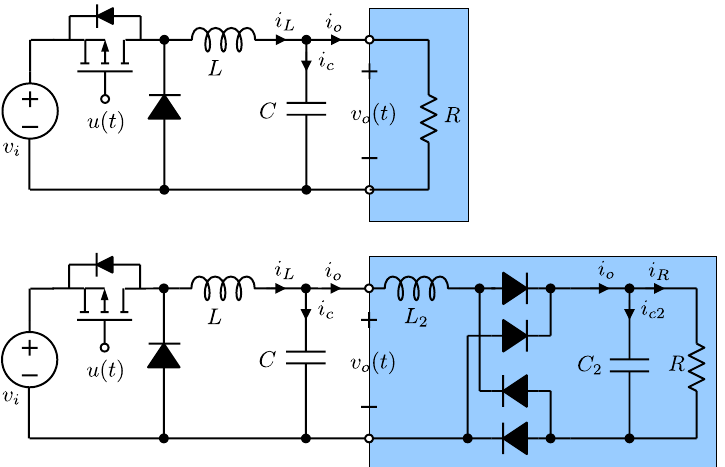
Figure 2. The converter’s schematic and control system with a resistive load ( above ) and nonlinear load ( below